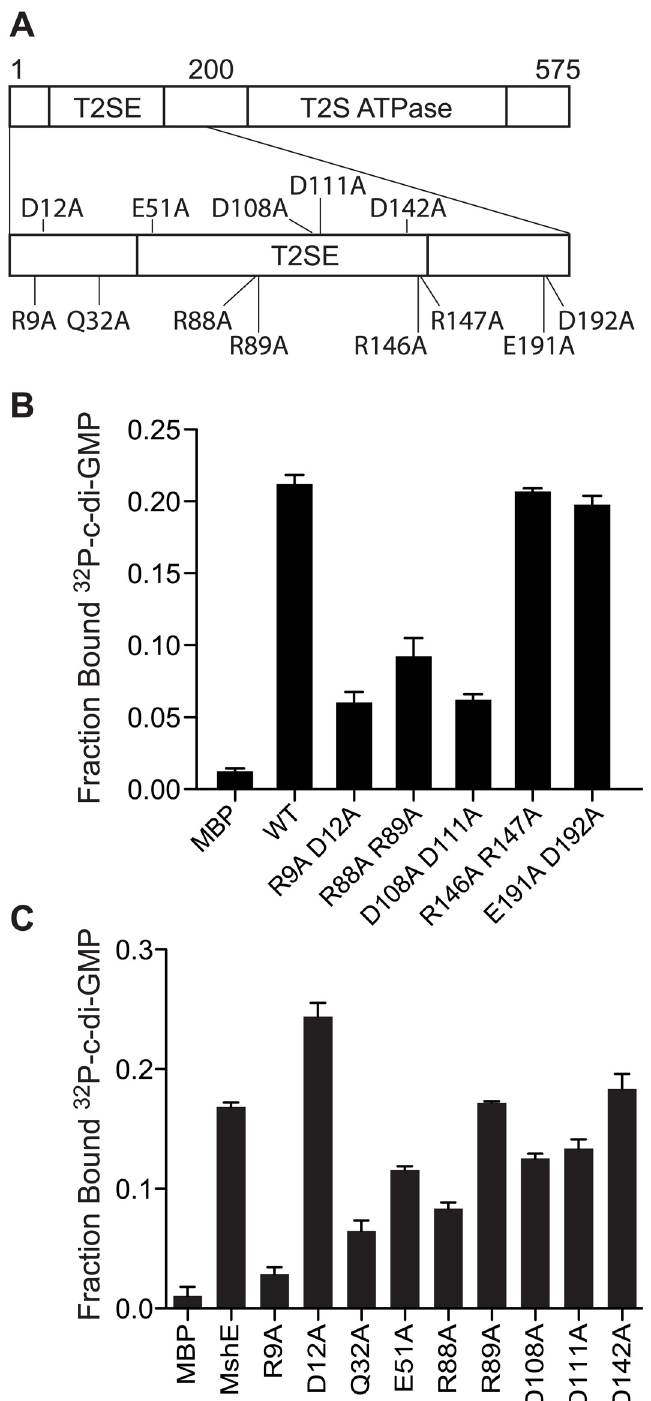
Fig 5. R9 is required for MshE to bind c-di-GMP. (A) Schematic of the charged and polar conserved residues in the first 200 amino acids of MshE targeted for site-directed alanine substitution. (B) Fraction bound of 32 P-c-di-GMP to purified MshE (WT) and indicated pairs of alanine substitutions. (C) Fraction bound of 32 P-c-di-GMP to purified MshE (WT) and indicated individual alanine substitution. All data are average of three independent assays and standard deviation is indicated by error